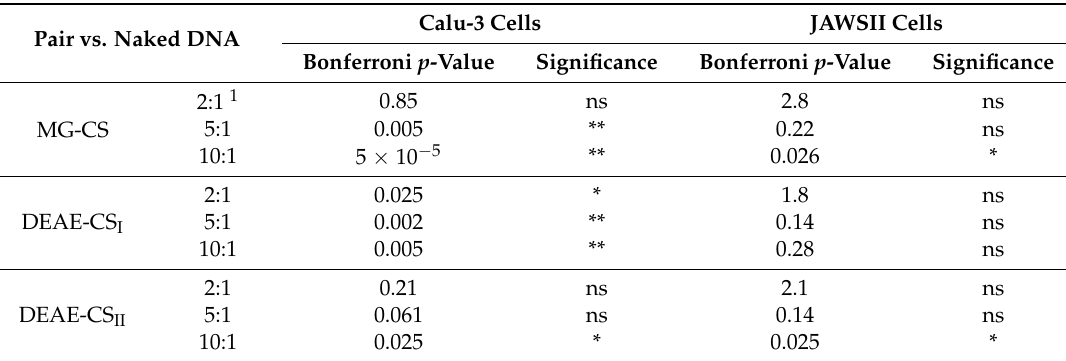
Table A1. Statistical analysis of the transfection